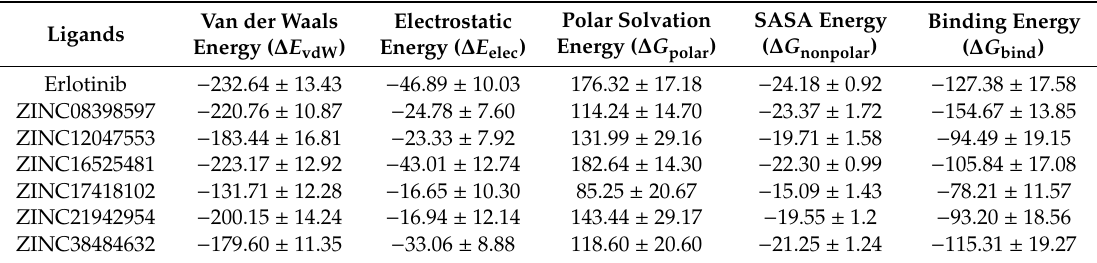
The predicted binding free energy and the individual energy components (kJ / mol) ligand-EGFR complexes.